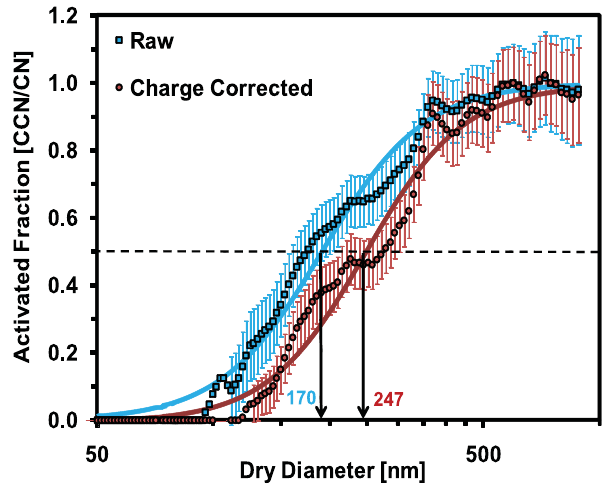
Fig. 3. Activation curves for Soil 2 at s c = 0 . 3%. Shown are inver- sions without (blue) and with multiple charge corrections (brown). Error bars represent uncertainty of activation efficiency as a result of counting efficiency and flow rate uncertainty at different